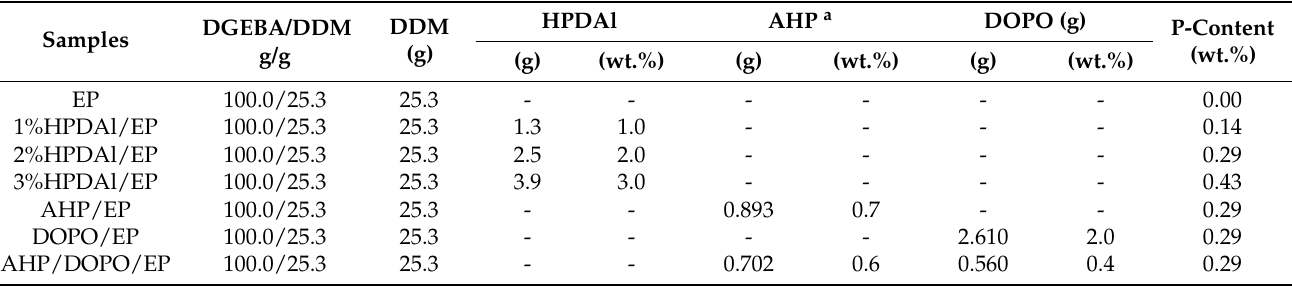
Table 1. The control samples were prepared according to the above procedure. Table 7. Formulation of the epoxy